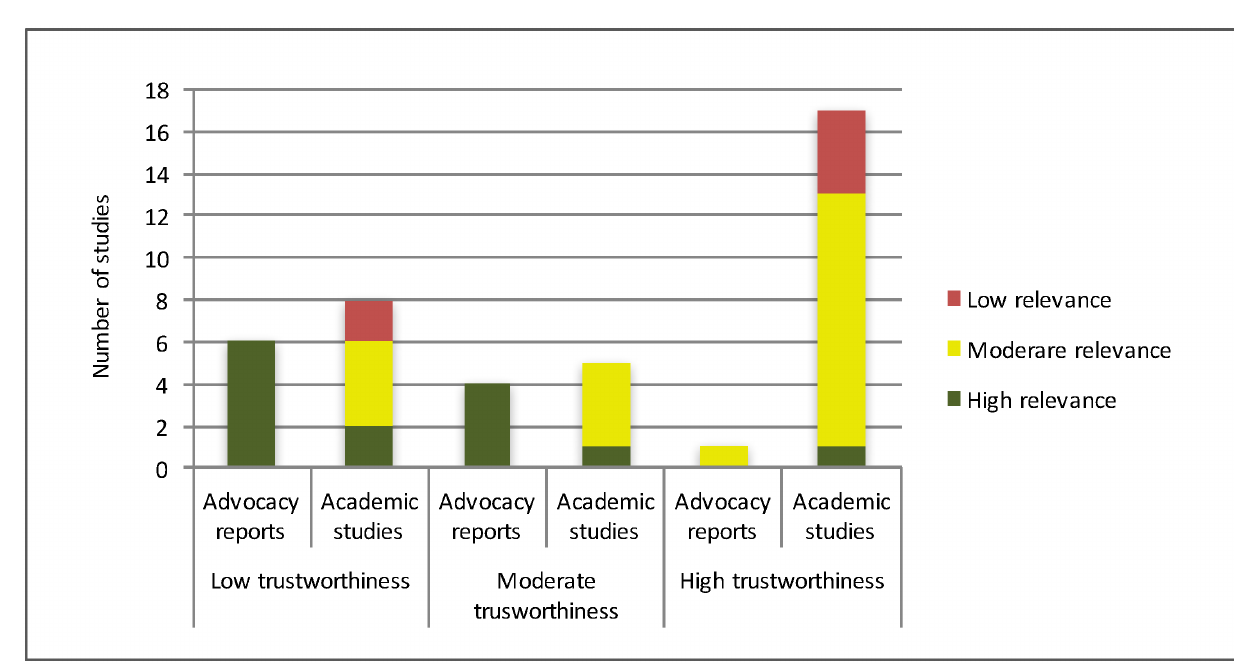
Fig 9. Weight of the